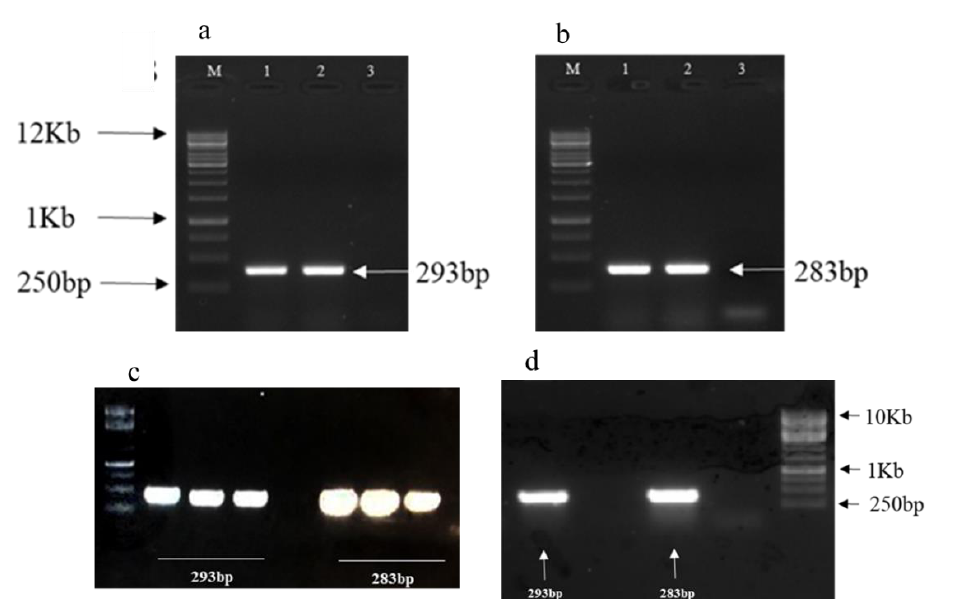
Figure 4. PCR amplification results of ( a ) 293 bp band of WRKY25 amplified from G. hirsutum cDNA and ( b ) 283 bp band of WRKY33 amplified from G. hirsutum cDNA, ( c ) 293 bp band of WRKY25 and 283 bp band of WRKY33 amplified from grown cultures of E. coli transformed cells, indicating the presence of recombinant TRV2 vector, ( d ) 293 bp band of WRKY25 and 283 bp band of WRKY33 amplified from grown cultures of transformed cells of GV3101 , indicating the presence of recombinant TRV2 vector.